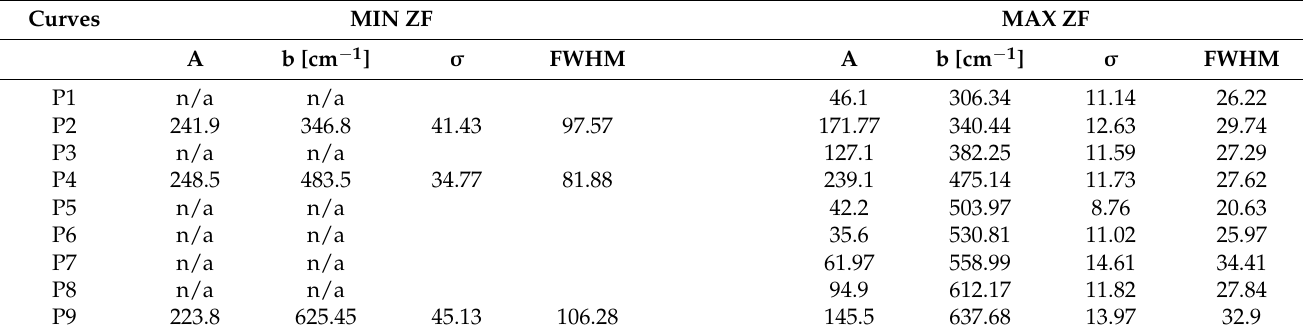
Table 1. Gaussian fit parameters for the obtained spectral